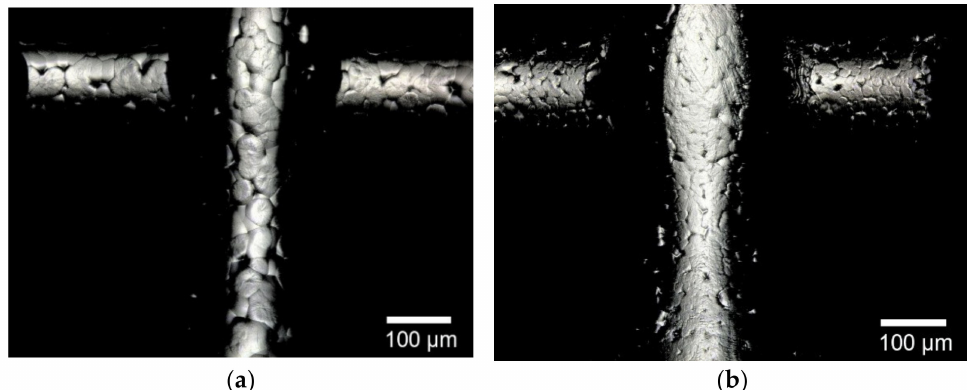
Figure 2. Comparison of surface roughness of ( a ): uncoated ( b ): collagen coated PCL scaffolds; images taken with KEYENCE VK-X210 3D Laserscanning microscope.